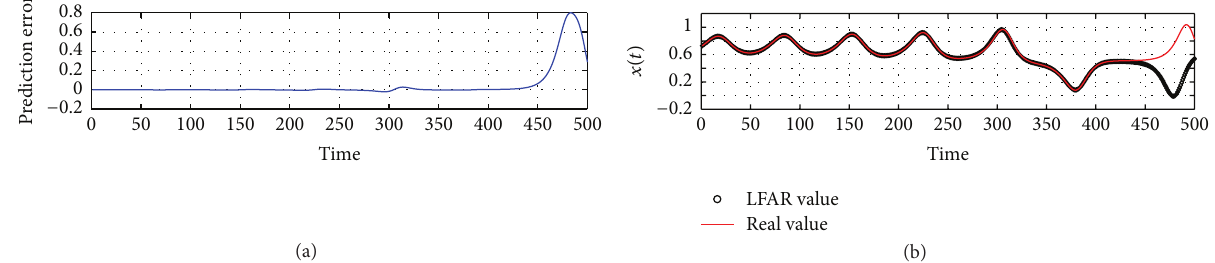
Figure1:ResultsofLorenztimeseries:(a)multisteppredictionerrorsand(b)theoriginalvaluesandmultisteppredictionvalues, respectively.